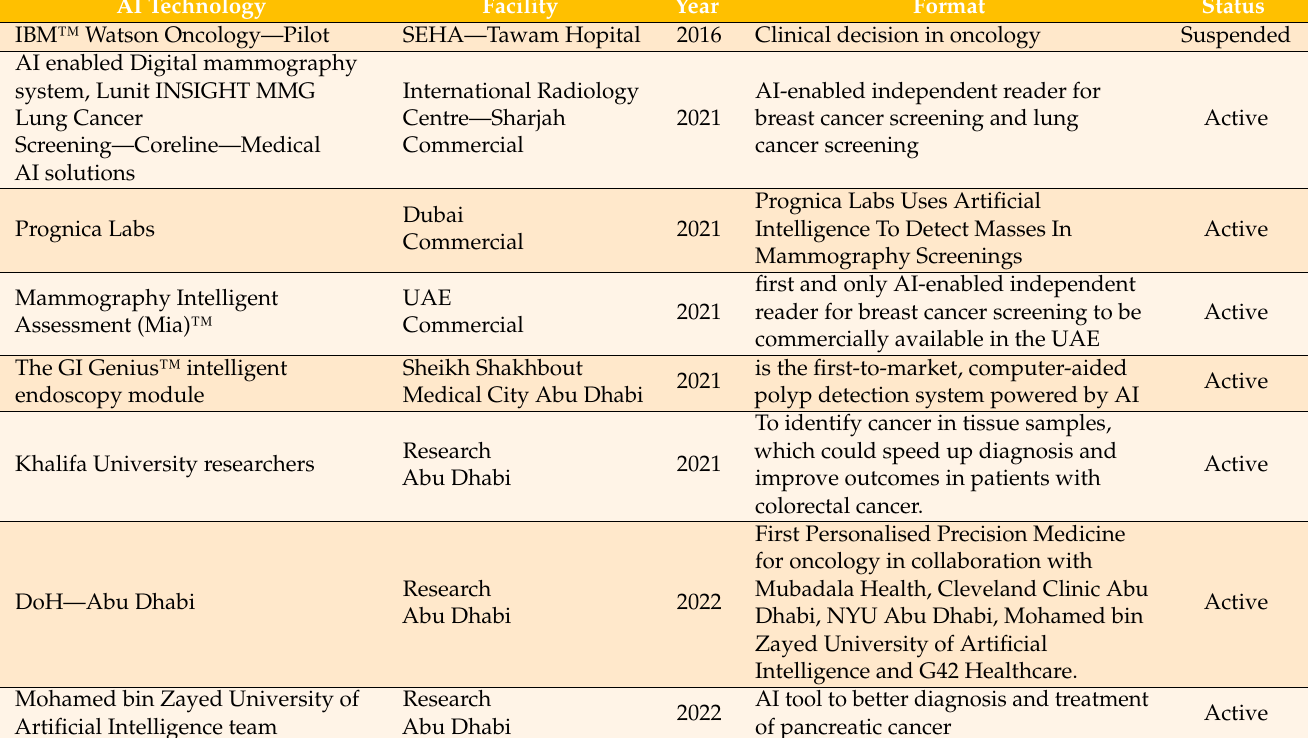
Table 9. Current status of clinical and research initiatives in the